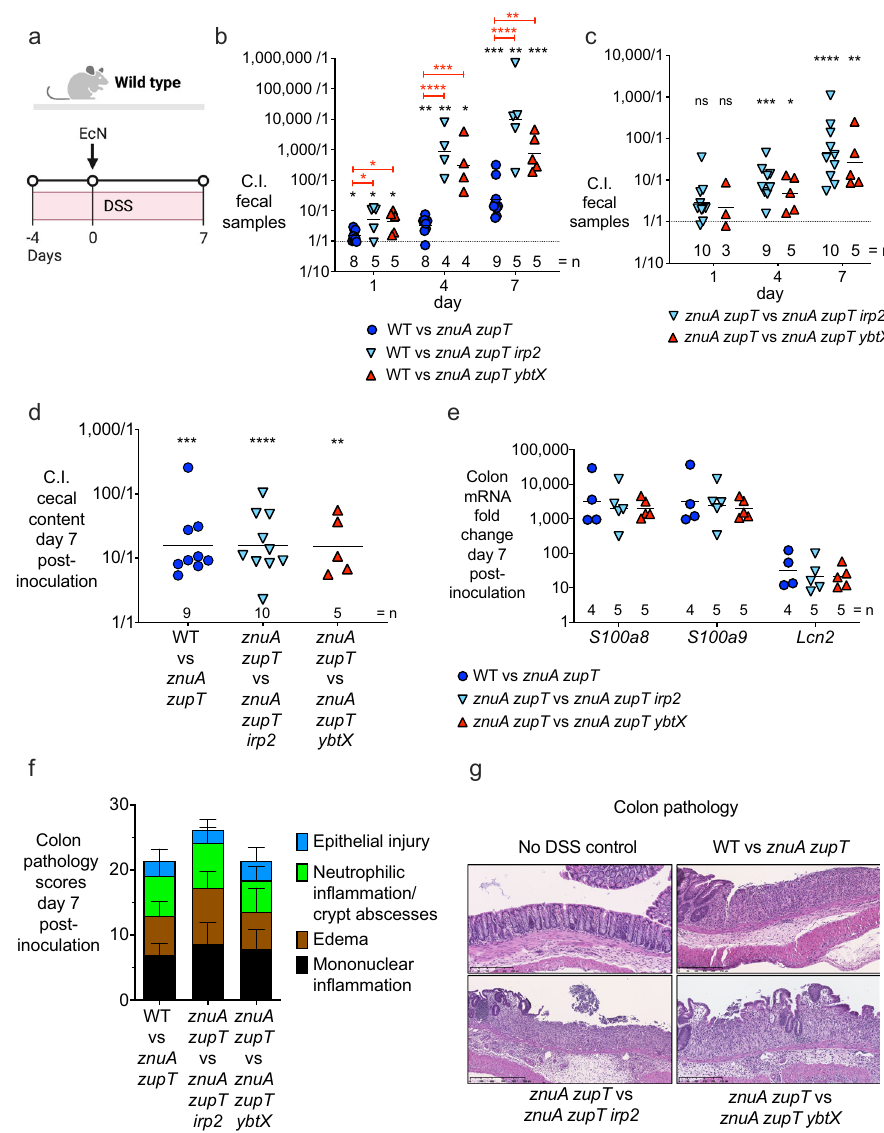
Fig. 4 The ability to acquire zinc via yersiniabactin enhances E. coli Nissle colonization of the in fl amed gut. a Experiment timeline for the DSS-induced colitis model and the administration of EcN strains. 8 – 10-week-old C57BL/6 female mice were given 4% (w/v) DSS in the drinking water for 4 days (day − 4 to 0). On day 0, mice were orally gavaged with 1 × 10 9 CFU of a 1:1 mixture of EcN strains. b , c Fecal samples were collected on day 1, 4, and 7, and the competitive index (C.I.) was calculated by dividing the output ratio. b CFU of wild type or c of the znuA zupT strain / CFU of the competing double or triple mutant strain in each group) by the CFU-enumerated input ratio of the strains. Two-sided one-sample t test was used on log-transformed data to accept or reject null hypothesis (theoretical mean = 0) (black stars). Statistical signi fi cance between groups was determined by one-way ANOVA and Dunnett ’ s multiple comparisons test of log-transformed data (red stars). d Cecal content was collected on day 7 and the C.I. of strains in the indicated groups